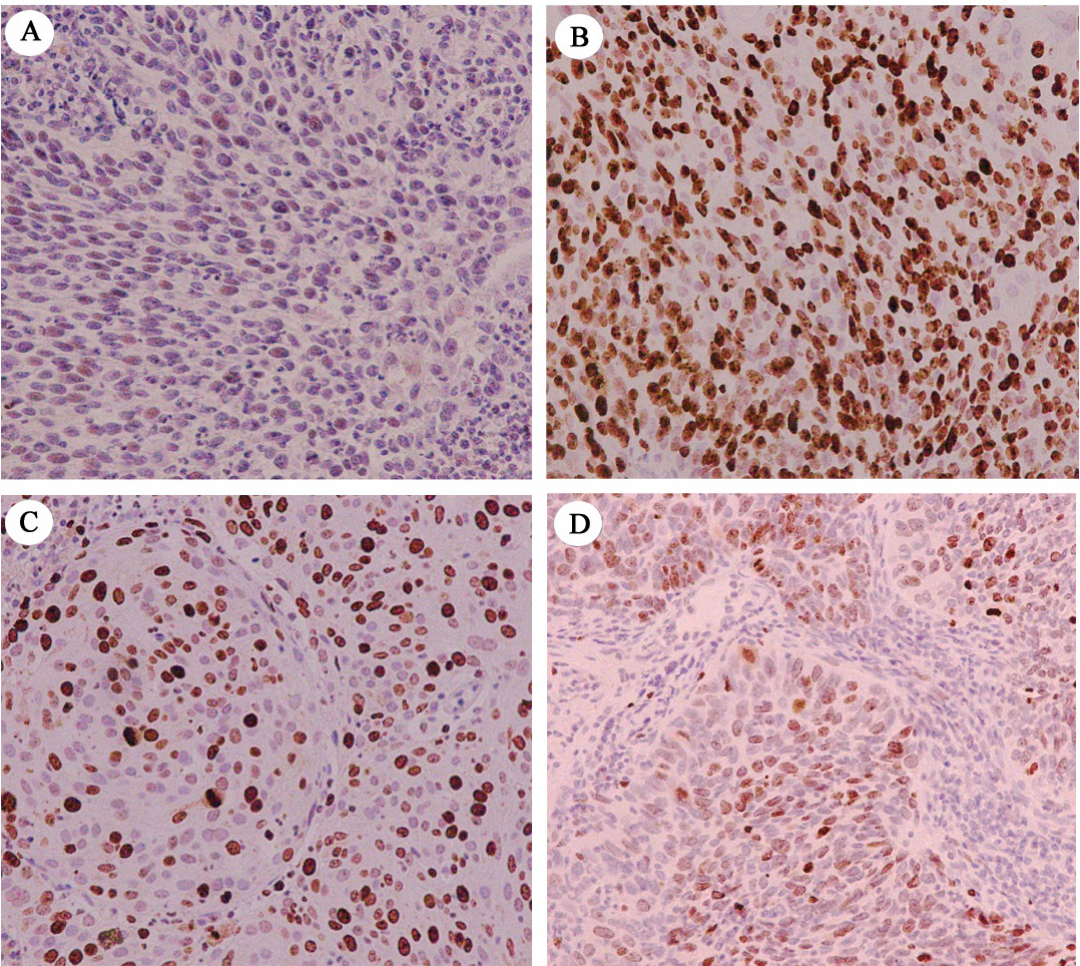
Figure 1. Expression of ESRP1 and Ki-67 in human cervical carcinoma tissues. ( A , B ) Low expression of ESRP1 and high expression of Ki-67 in a single cervical carcinoma sample, respectively. ( C , D ) High expression of ESRP1 and low expression of Ki-67 in another cervical carcinoma sample, respectively. (200×).